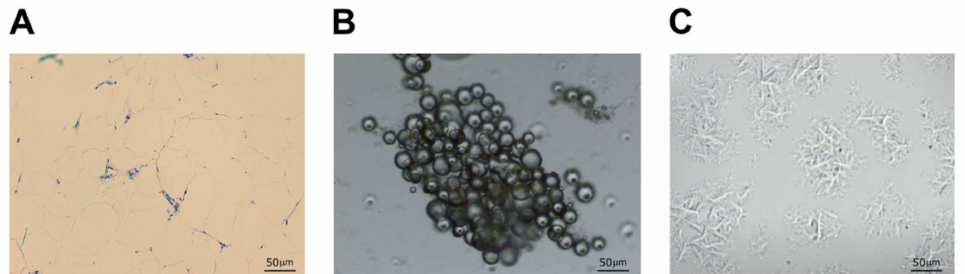
Figure 2. Autologous adipose tissue and adipocyte-derived mesenchymal cell morphology. Histo- logical analysis of the adipose tissue ( A ) was observed under a light microscope. Nuclei are stained with hematoxylin (purple) and cytoplasmic components with eosin (pink). The morphology of the Lipogems product (day 1, ( B )) and adipose-derived mesenchymal stem cells (day 28, ( C )) was observed and photographed using a light microscope